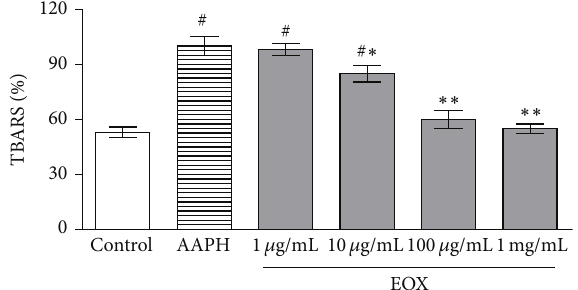
Figure 1: TBARS in vitro . Lipid extracted from egg yolk was subjected to oxidative damage by incubation with AAPH, and the ability of differentconcentrationsofEOXtopreventTBARSformationwasanalyzed.Controlmeansbasallipidperoxidationwithvehiclealone(DMSO 10%); AAPH alone group is considered as 100% of oxidative damage. Values represent mean ± S.E.M., 𝑛 = 4 , experiments in triplicate. # 𝑃 < 0.001 versus control; ∗ 𝑃 < 0.05 and ∗∗ 𝑃 < 0.001 different versus AAPH group (system) (ANOVA followed by Tukey’s test).